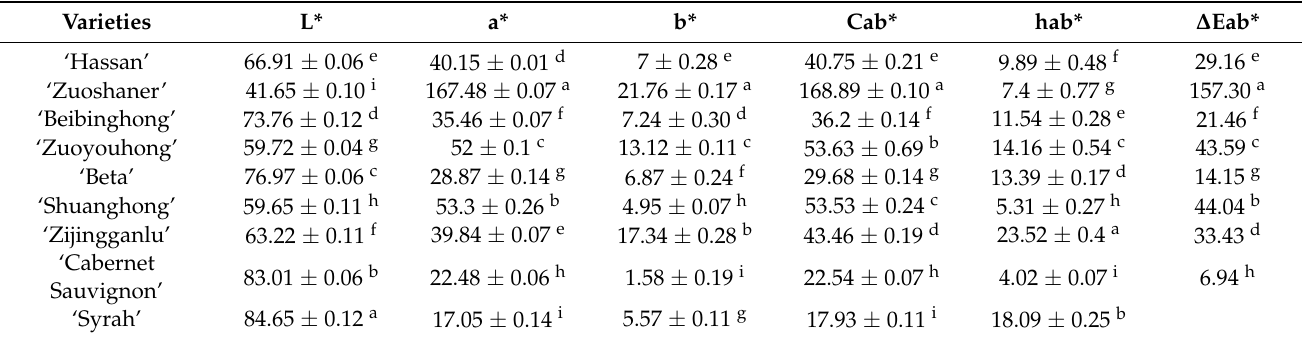
Table 4. CIELab parameters of different original